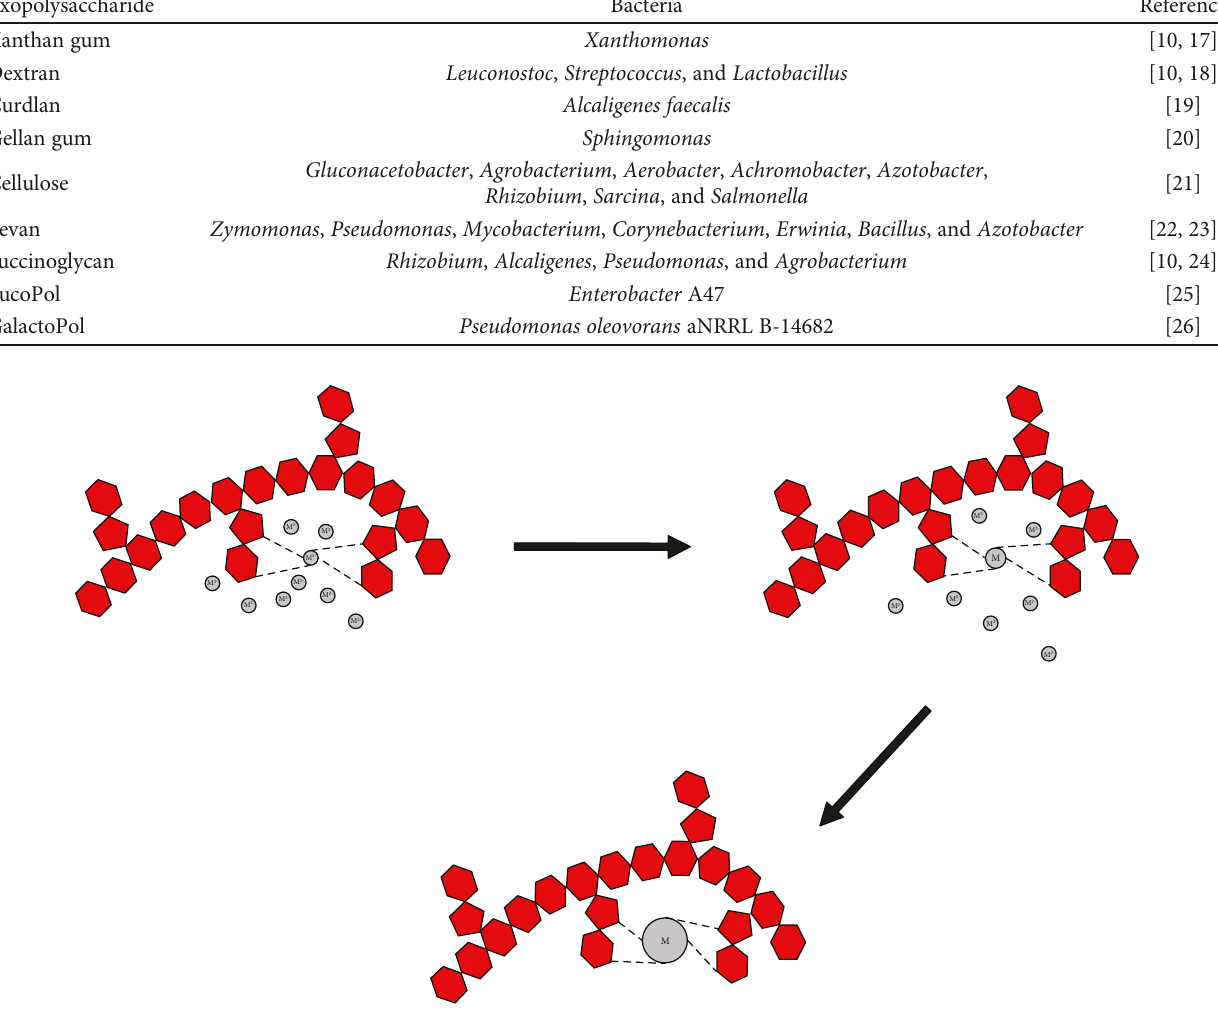
Figure 2: General representation of EPSs as a reducing and stabilizer agent to produce metal nanoparticles. Metal ions can be coordinated by the functional groups of the exopolysaccharide. Then, the metal can be reduced either by the exopolysaccharide or a di ff erent reducing agent. Once the nuclei was formed, it can grow stabilized by the microbial